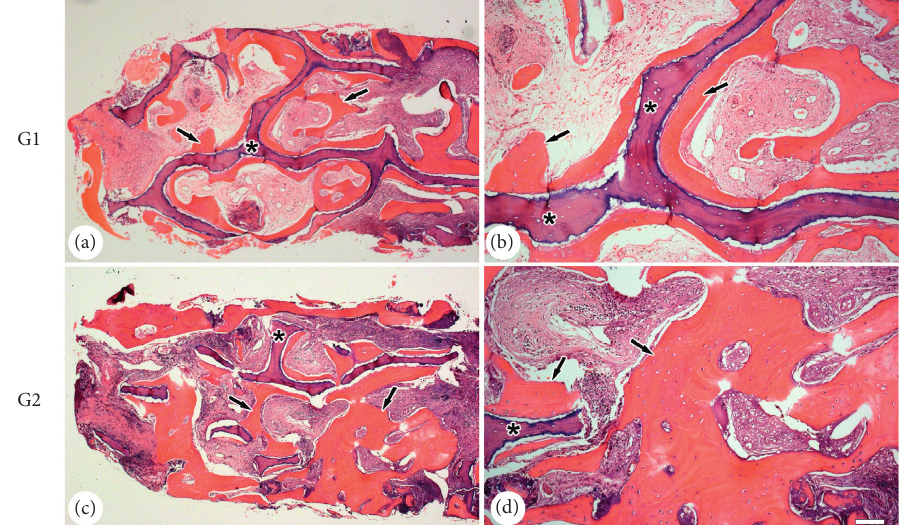
Figure 3: Histological images stained with hematoxylin and eosin from the trephined areas with different treatments. Detailed images show the presence of newly formed bone ( ⟶ ) and the presence of remaining biomaterials ( ∗ ) . (a)-(b) Group 1 (G1), xenograft associated with peripheral blood. (c)-(d) Group 2 (G2), xenograft associated with mandibular bone marrow blood aspirate. Bars: (a) and (c) � 1,000 µ m; (b) and (d) � 100 µ